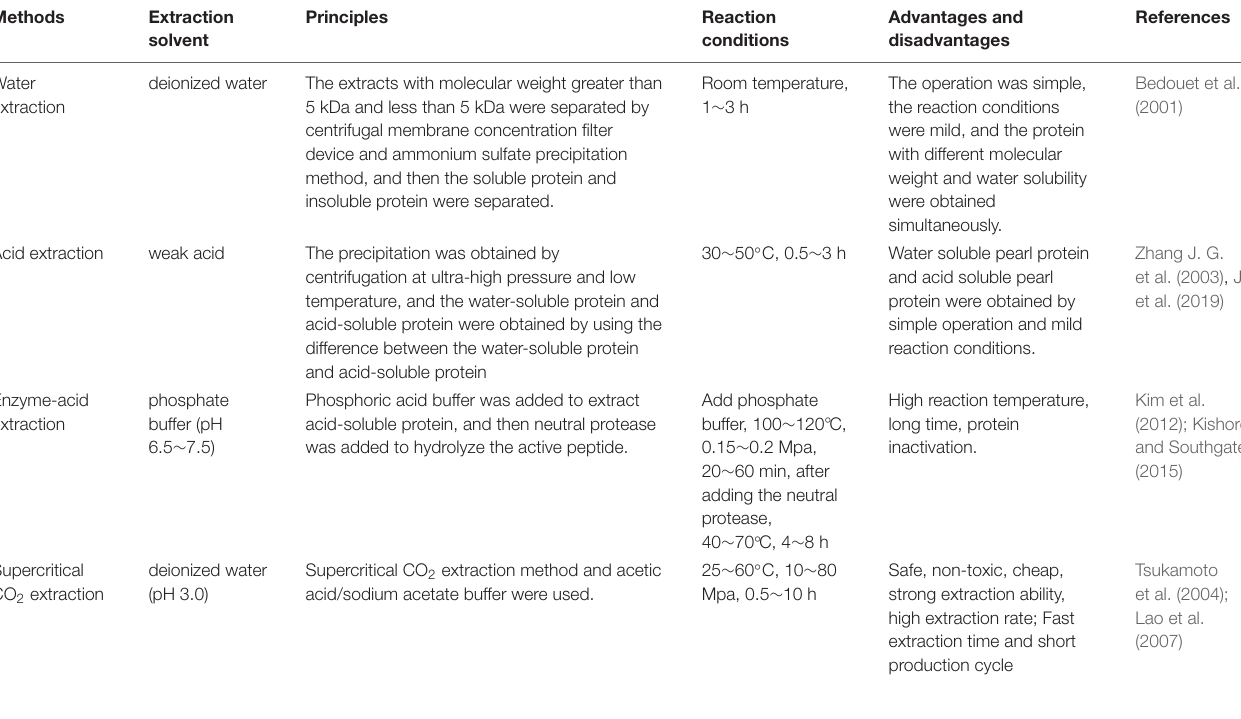
TABLE 2 | Summary of the extraction and purification processes of pearl powder matrix protein.